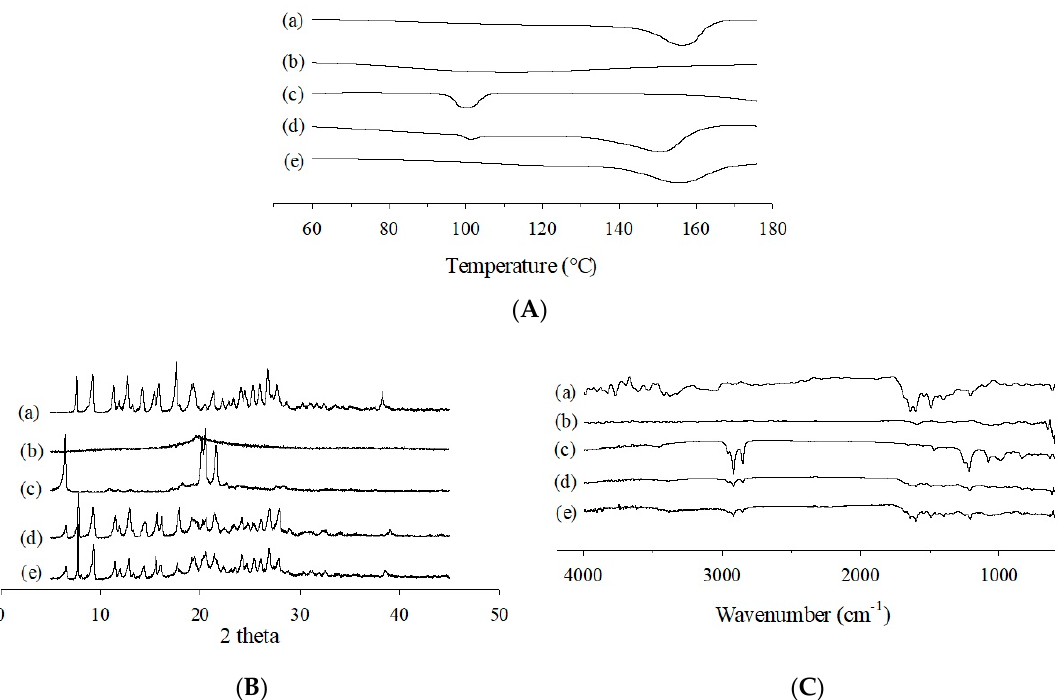
Figure 4. DSC ( A ), PXRD ( B ), and FTIR ( C ) curves of the MTX powder ( a ), Na-CMC ( b ), SLS ( c ), physical mixture ( d ), and F6 formulation ( e ).